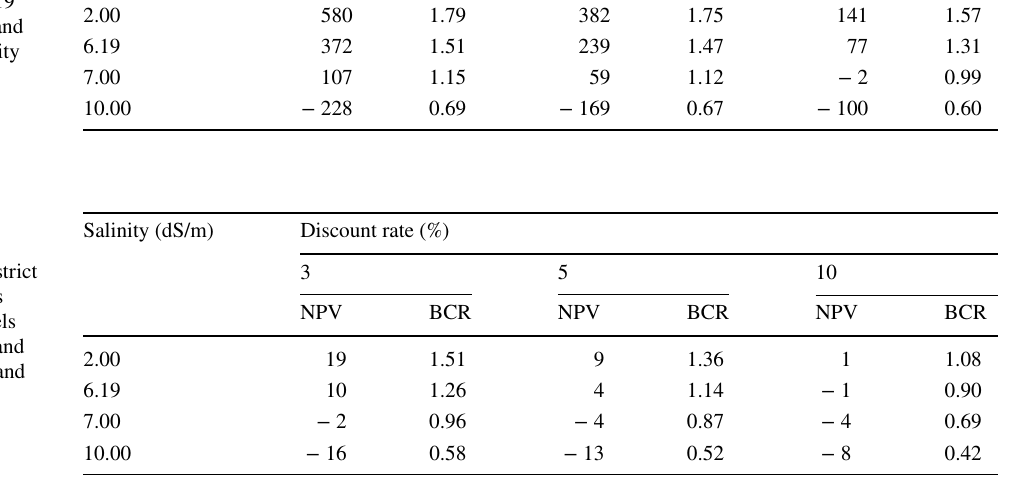
of date palm cultivation in million USD for Tubas District under various discount rates (3, 5, 10%) and salinity